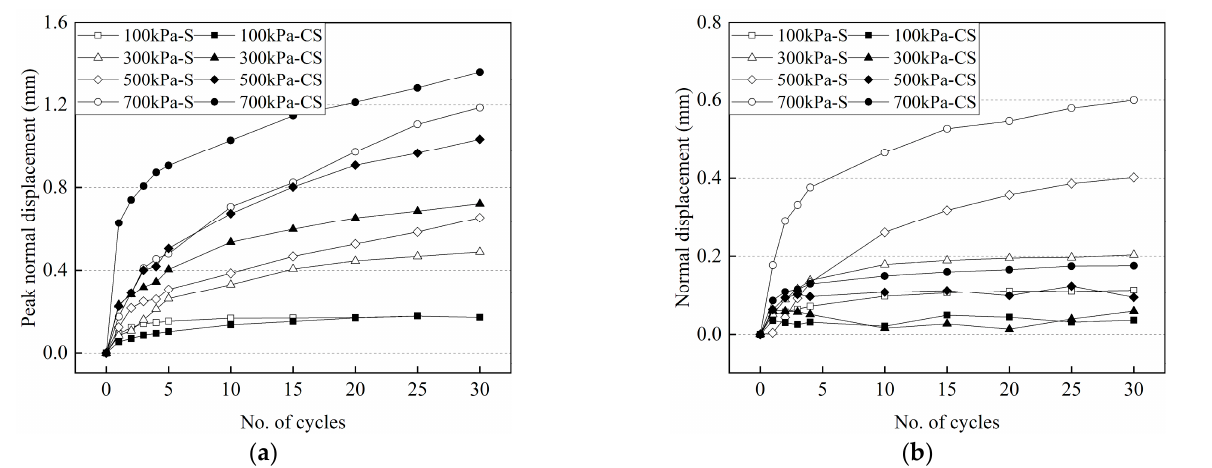
Figure 22. Differences of normal displacement between frozen cement-treated sand–concrete and frozen sand–concrete interfaces. ( a ) − 2 °C; ( b ) − 14 °C.